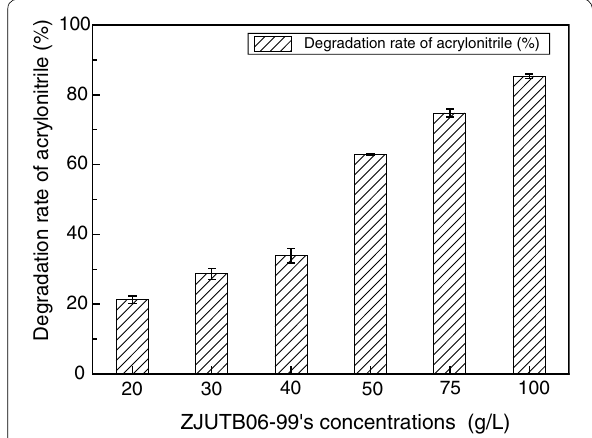
Fig. 9 Influence of ZJUTB06-99’s concentration on the biodegradation. The effect of ZJUTB06-99’s concentration on the acrylonitrile’s biodegradation rate. The factor of ZJUTB06-99’s concentration showed the strongest influence on the response when it varied in the range of 20 to 100 mg/L. Especially, the degradation rate of acrylonitrile reached to 85.3% with the ZJUTB06-99’s concentration of 100 g/L. The results could be justified by the higher amounts of effective enzymes that were produced as the concentration of ZJUTB06-99 were